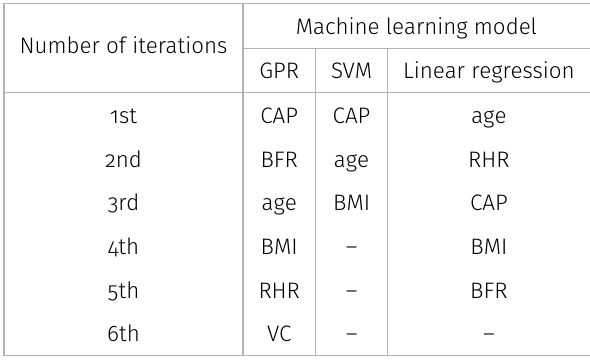
Table III. Feature selected in each iteration by each model. Machine learning model Number of iterations GPR SVM Linear